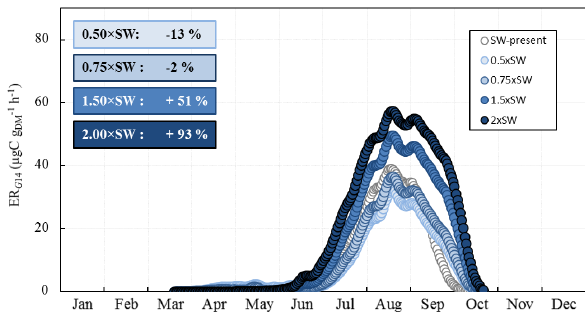
Figure 9. Sensitivity of the seasonal variation of isoprene emission rates calculated using G 14 (ER G 14 , in µgCg − 1 all annual relative changes to present (2000–2010) are